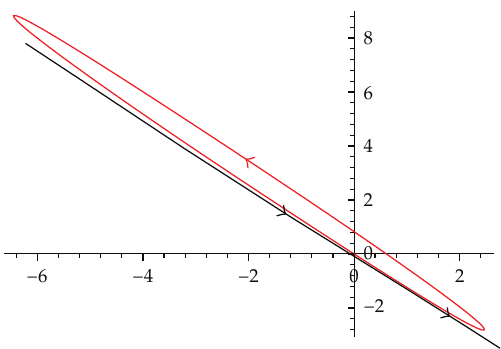
Figure 1: The particular solution to S (cid:2) X,Y (cid:3)